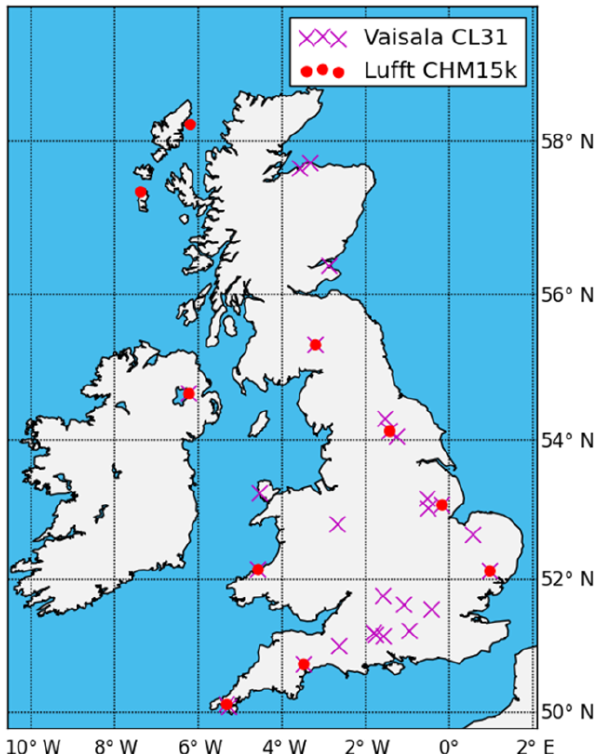
Figure 1. Location of Met Office ceilometers which record the full profile of attenuated backscatter. The Vaisala CL31s are indicated by a purple cross and the Lufft CHM15k by red dots.